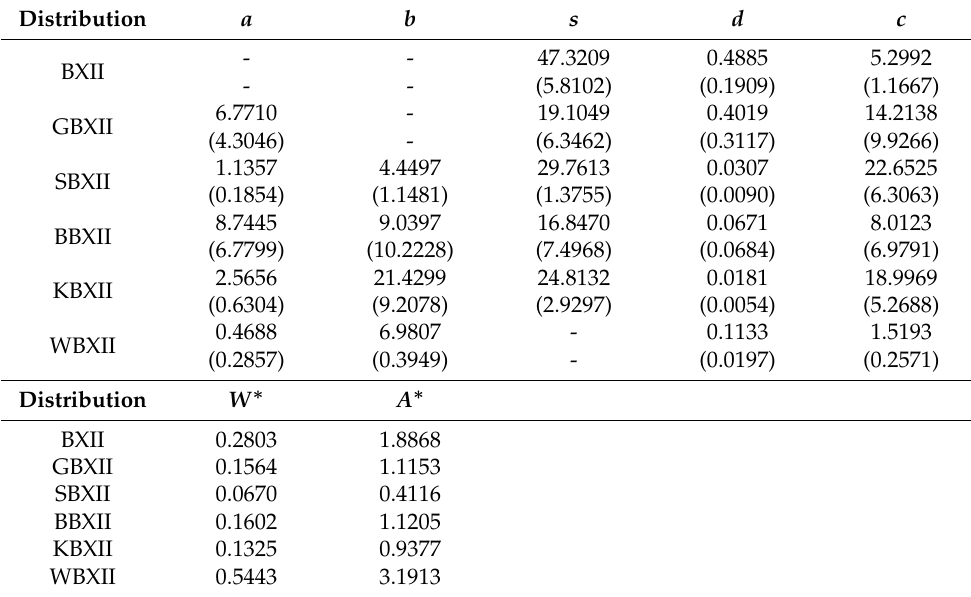
Table 3. Results from the fitted models to skin folds